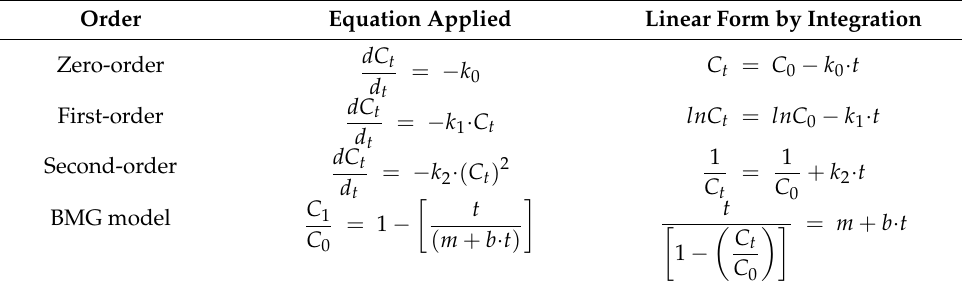
Table 1. Kinetic modelling